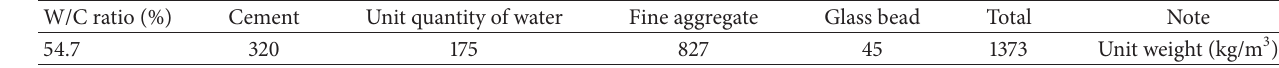
Table 1: Mixing data for insulating concrete.